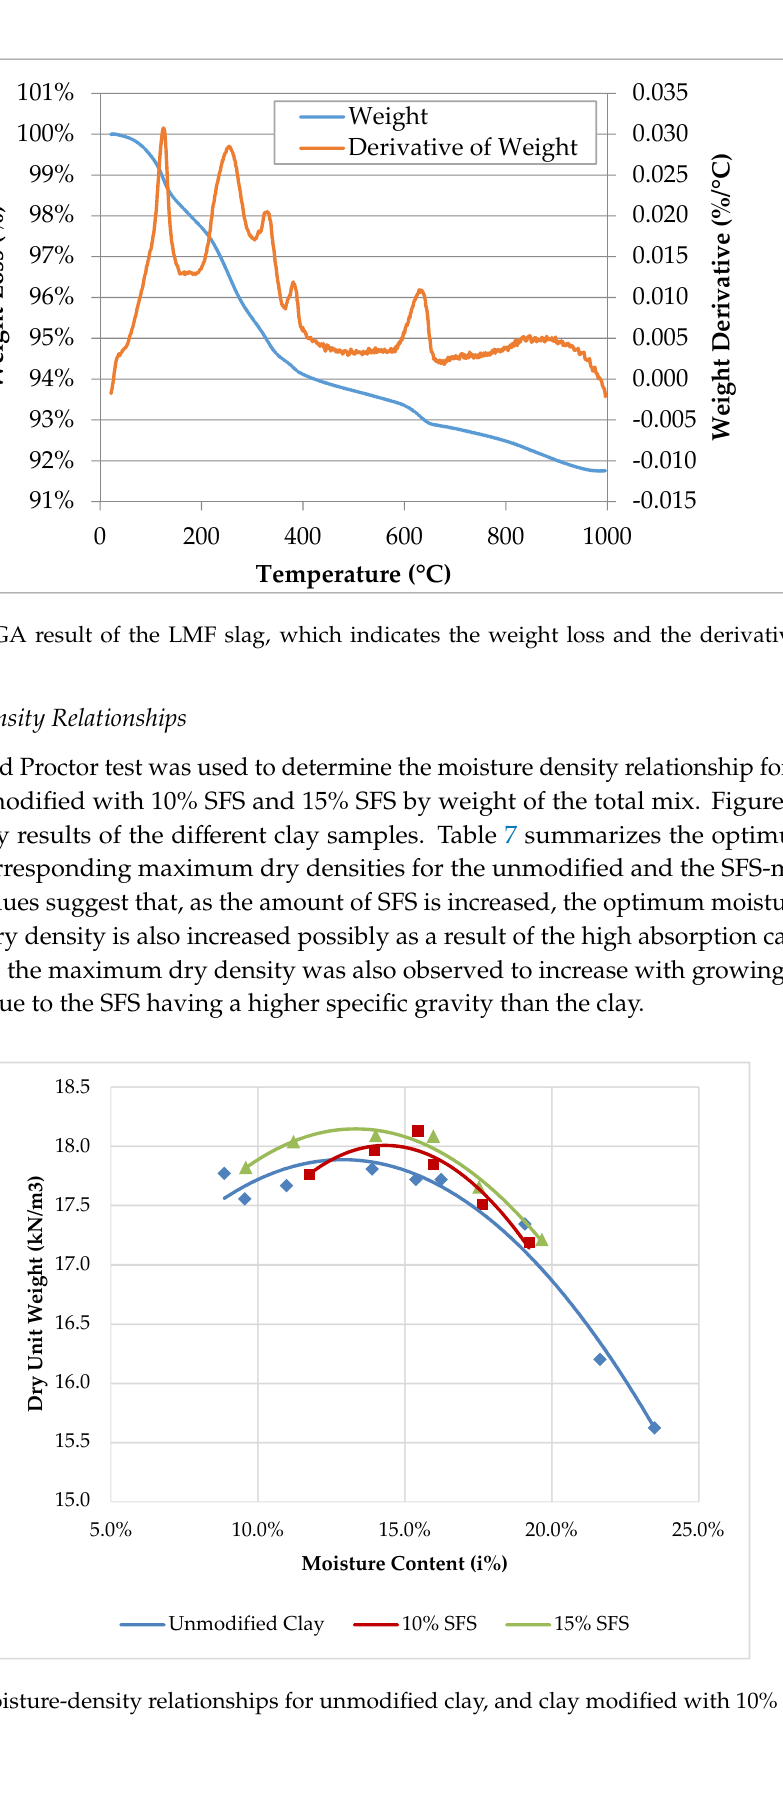
Figure 3. Moisture-density relationships for unmodified clay, and clay modified with 10% SFS, and 15% SFS. Table 7. Optimum moisture content and maximum dry density values for the unmodified and SFS- modified clay.